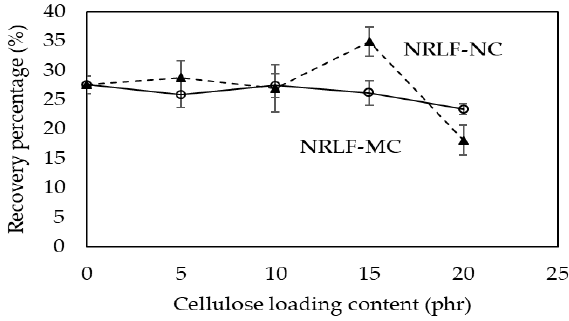
Figure 7. Recovery (%) from the compression test of NRLF, NRLF-MC and NRLF-NC.